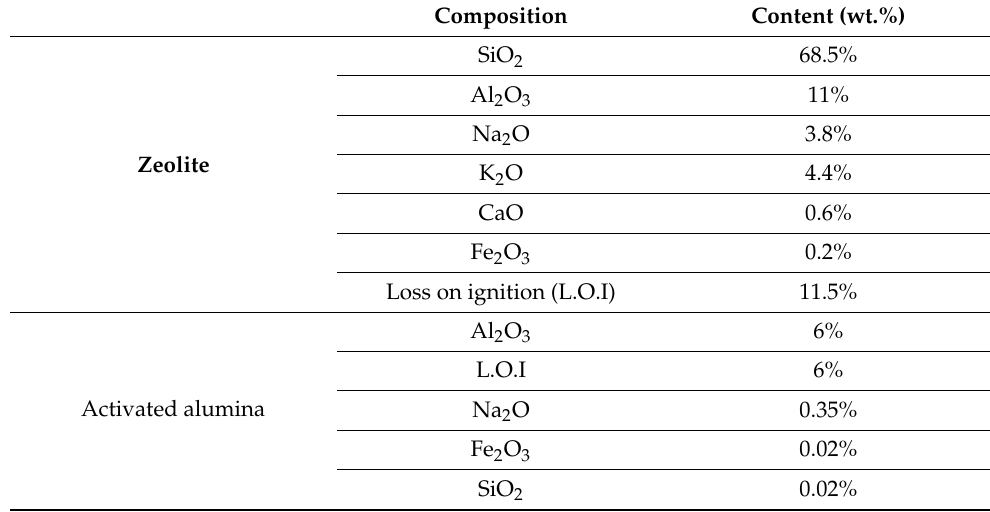
Table 1. Characteristics of natural zeolite clinoptilolite and activated alumina.